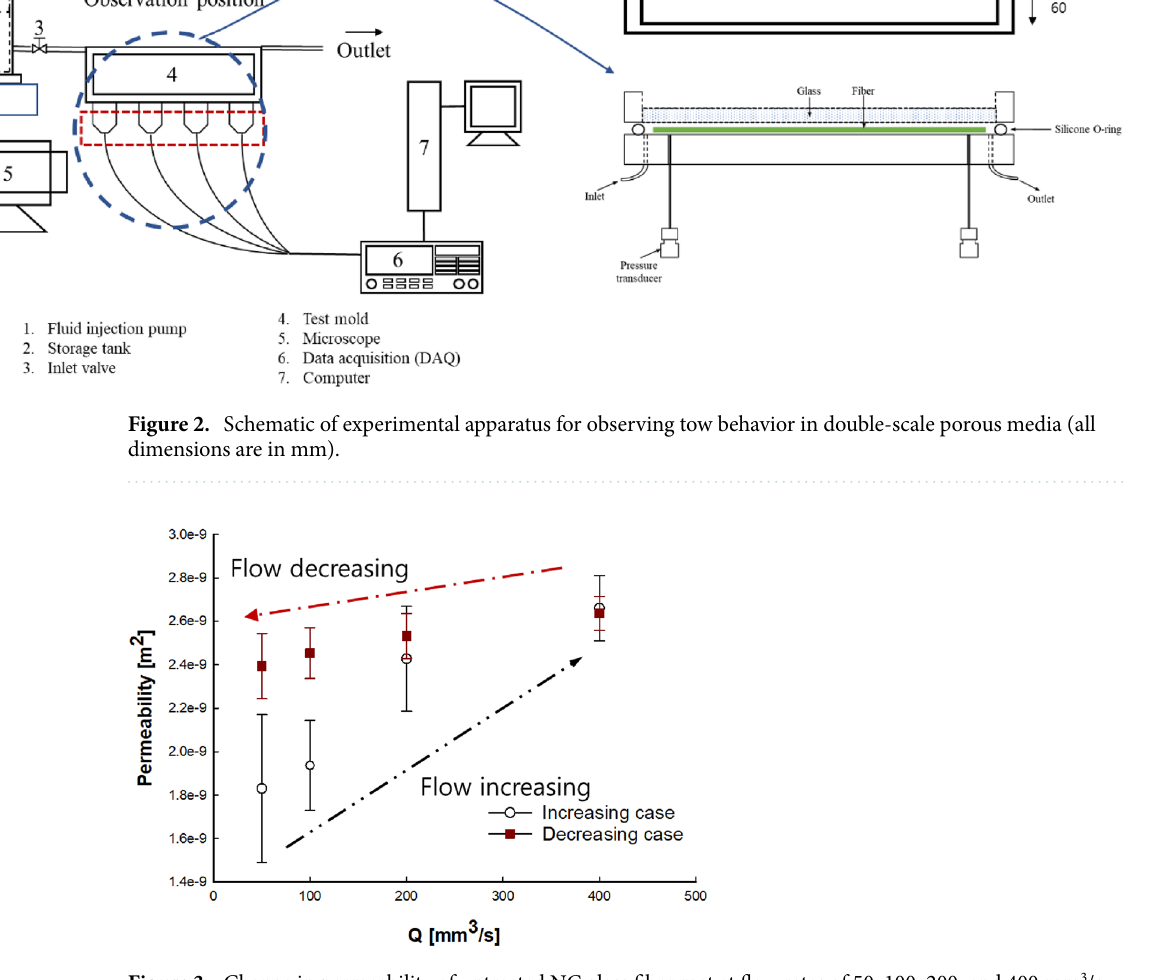
Figure 3. Change in permeability of untreated NC glass fiber mat at flow rates of 50, 100, 200, and 400 mm 3